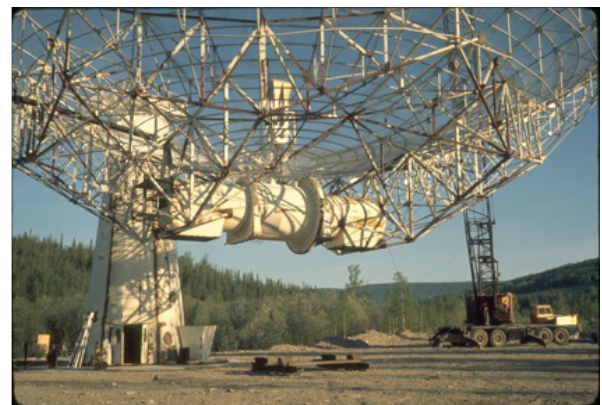
Figure 2. The assembly of the ISR in Chatanika, Alaska, in 1971.